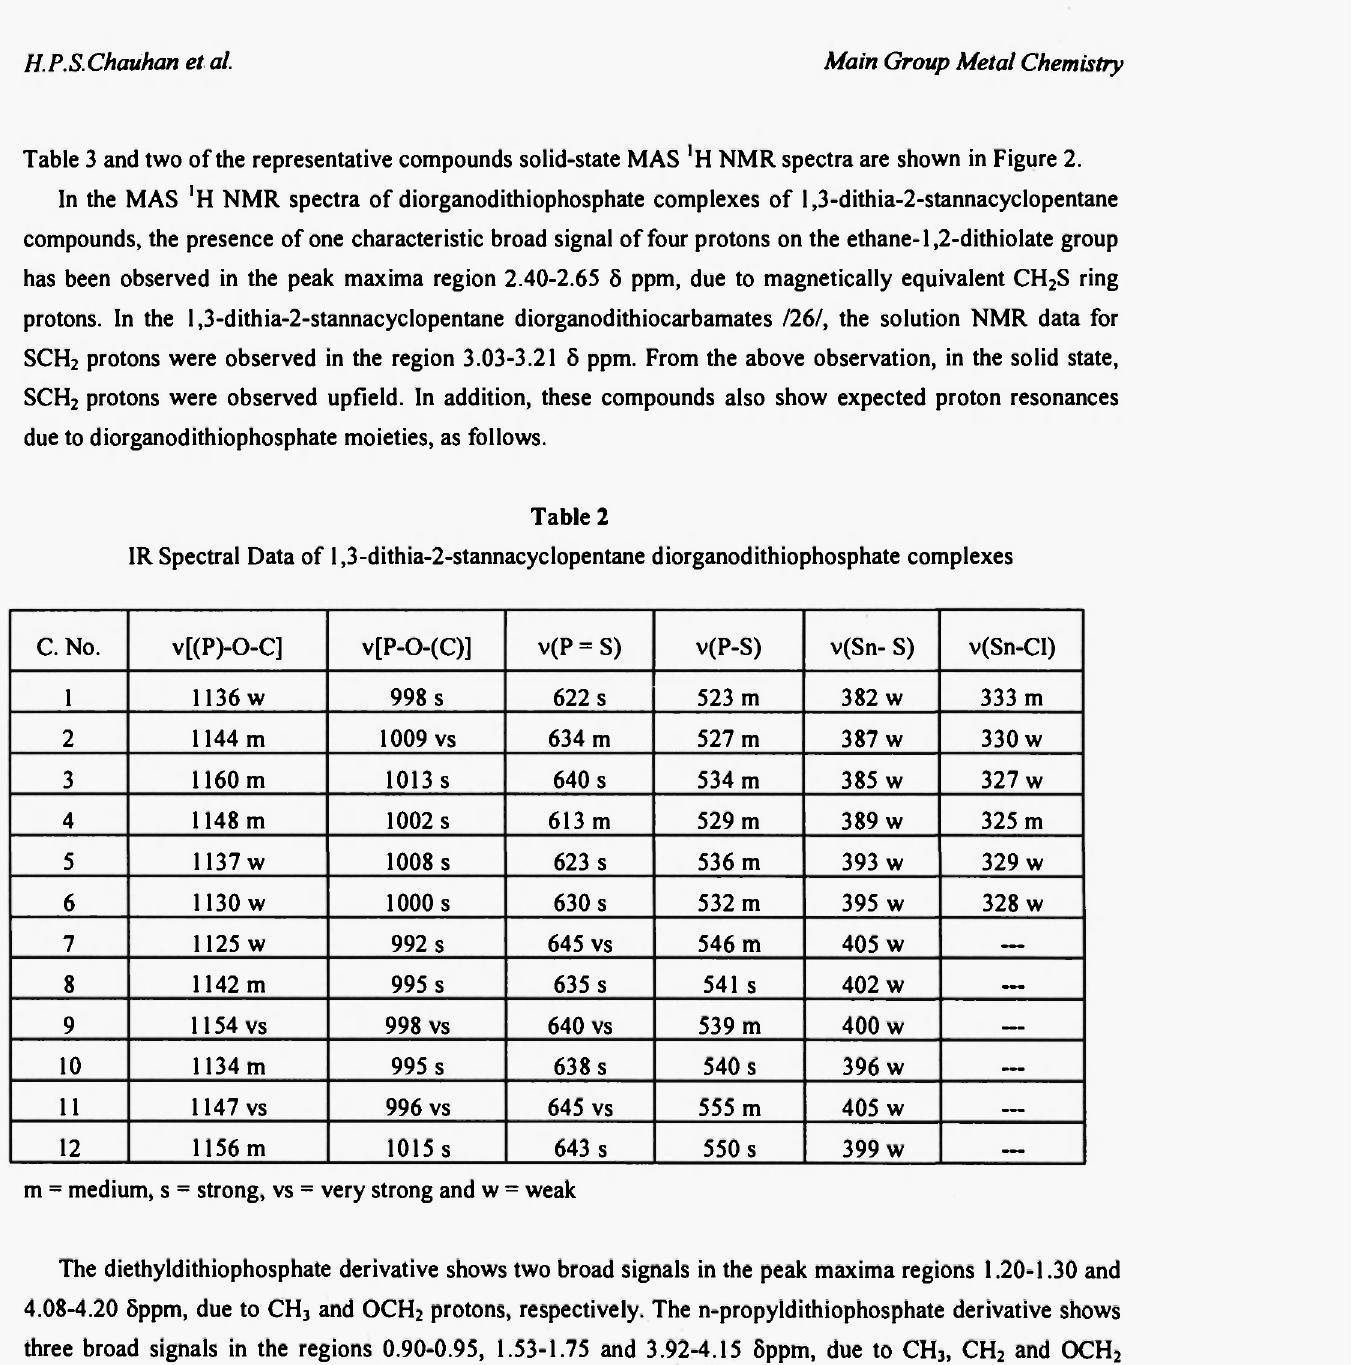
Table 3 and two of the representative compounds solid-state MAS 'H NMR spectra are shown in Figure 2. In the MAS 'H NMR spectra of diorganodithiophosphate complexes of l,3-dithia-2-stannacyclopentane compounds, the presence of one characteristic broad signal of four protons on the ethane-1,2-dithiolate group has been observed in the peak maxima region 2.40-2.65 δ ppm, due to magnetically equivalent CH 2 S ring protons. In the l,3-dithia-2-stannacyclopentane diorganodithiocarbamates 1261, the solution NMR data for SCH 2 protons were observed in the region 3.03-3.21 δ ppm. From the above observation, in the solid state, SCH 2 protons were observed upfield. In addition, these compounds also show expected proton resonances due to diorganodithiophosphate moieties, as follows.